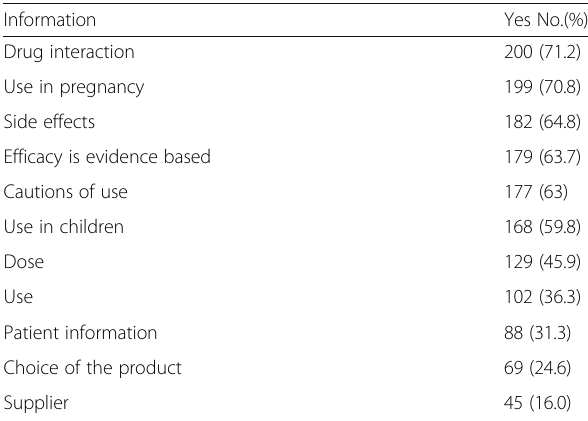
Table 7 Types of information needed in order to make appropriate recommendations by the pharmacists about CAM